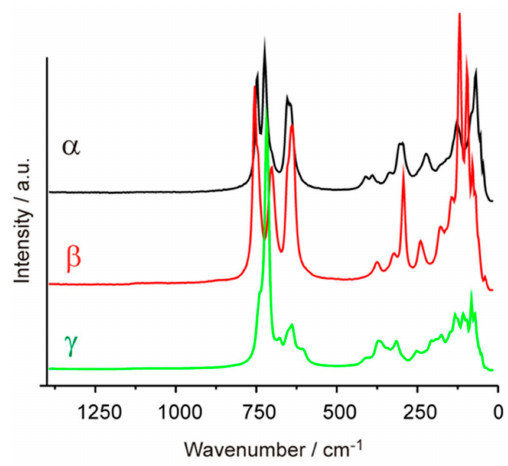
Figure 5. Raman spectra of the three PbTeO 3